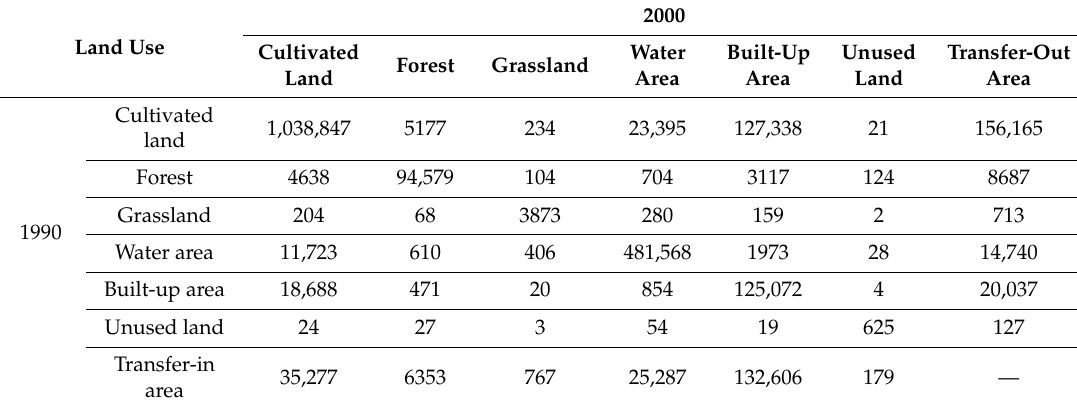
Table 5. Transition matrix of land-use change from 2000–2010 (ha).